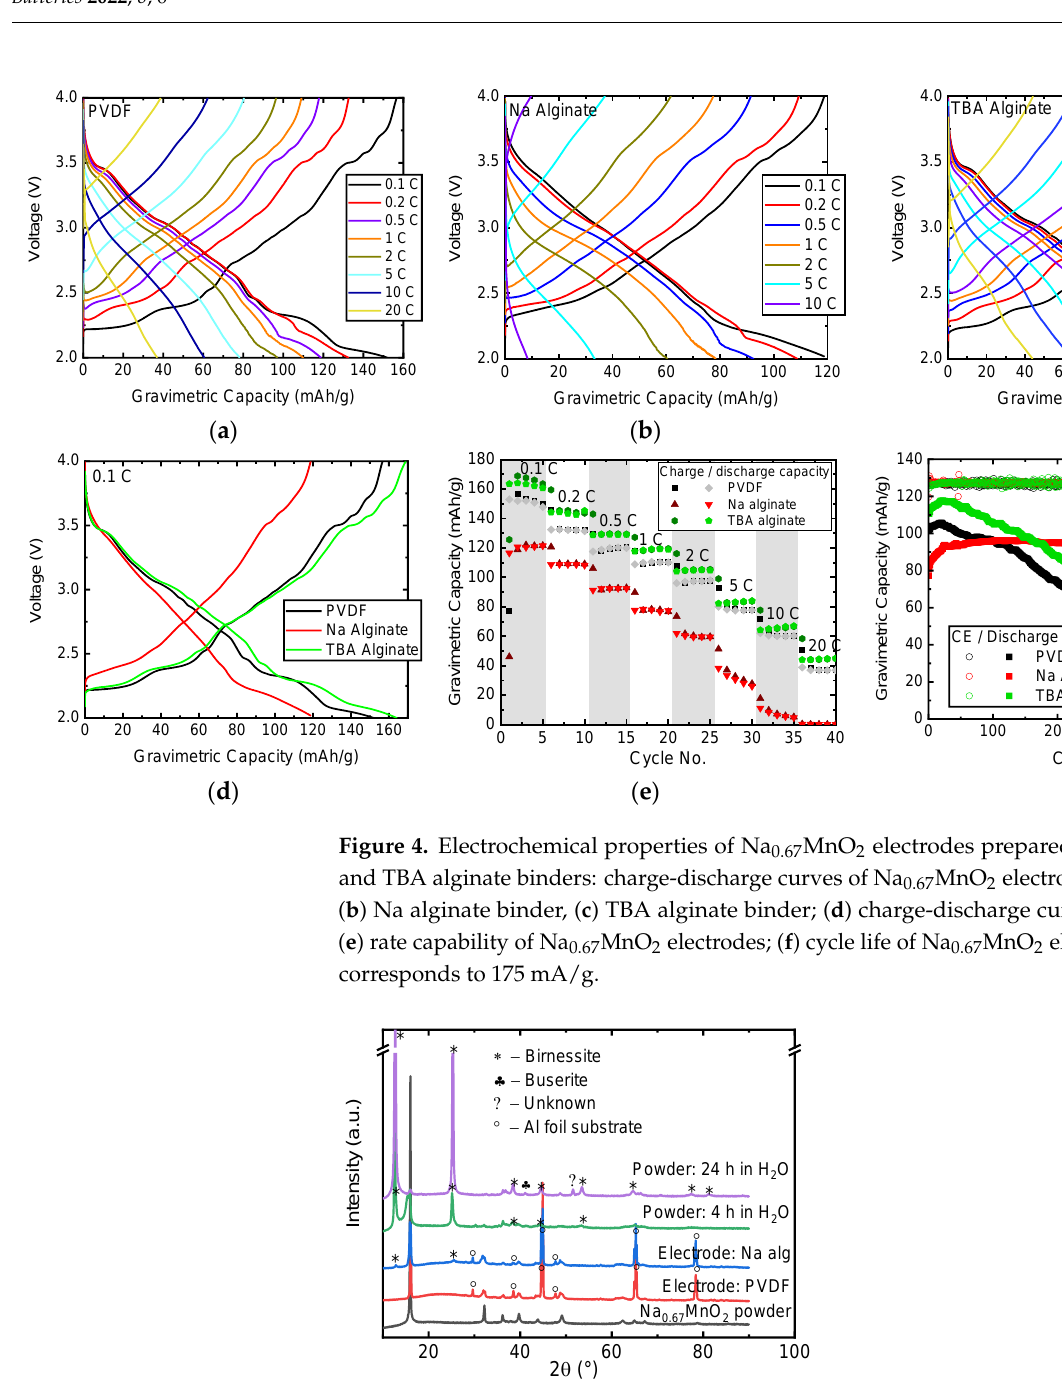
Figure 5. XRD of Na 0.67 MnO 2 electrodes prepared with PVDF and Na alginate binders, and Na 0.67 MnO 2 powder — pristine and after 4 h and 24 h of water exposure.